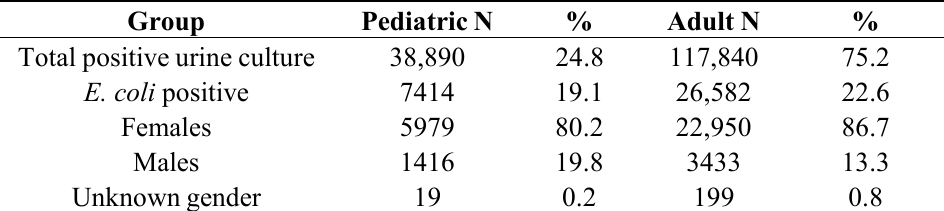
Table 1. Patient demographics (N = number).